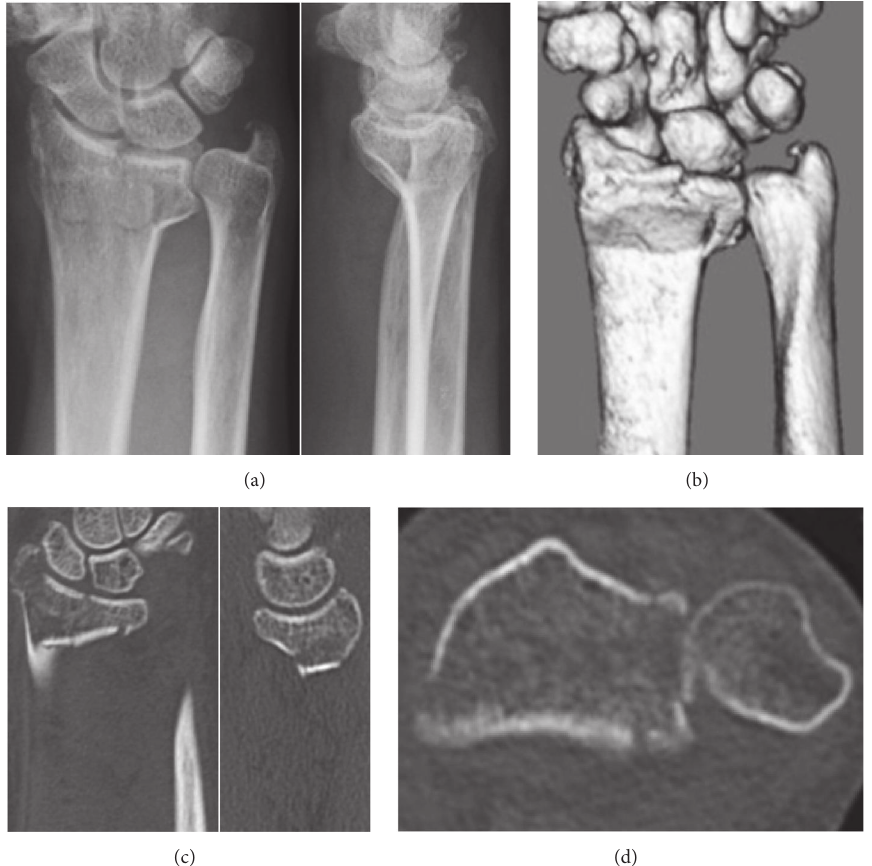
Figure 3: Patient 2. Plain radiographs (a) and CT (b, c, d) at the time of injury. A 12 × 12mm VLF fragment is observed, with volar